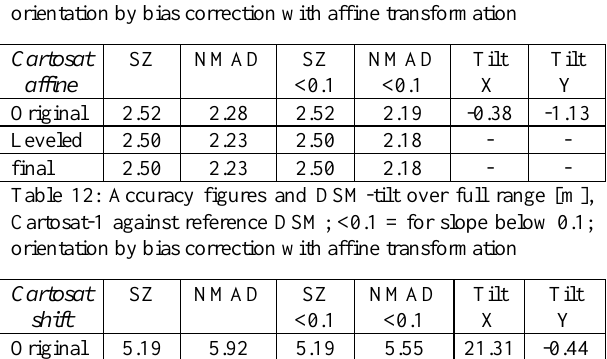
Table 11: Accuracy figures and DSM-tilt over full range [m], Pléiades against reference DSM; <0.1 = for slope below 0.1;